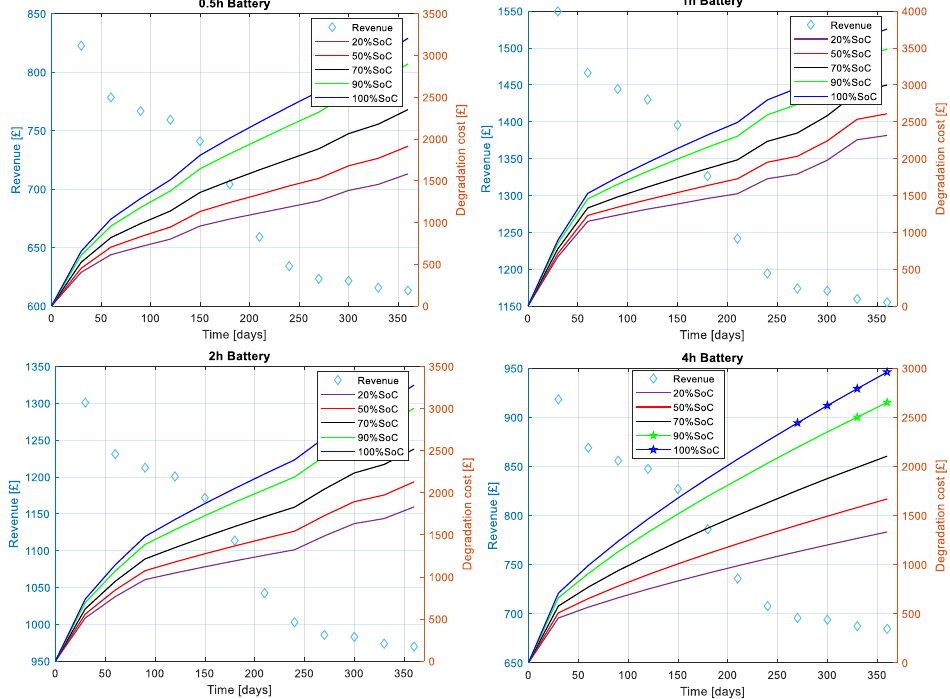
Figure 10. Revenue and degradation cost for 0.5h - 4 h batteries at several SoCs at T = 25 °C. * means a penalty is applicable on this battery at this time. Capacity fade is predicated by Formula (18).